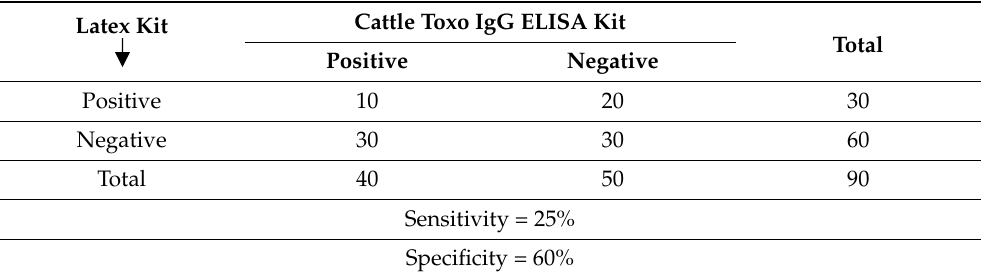
Table 7. Calculation of sensitivity and specificity of Latex Agglutination kit against Cattle Toxo IgG ELISA kit ( n = 90).